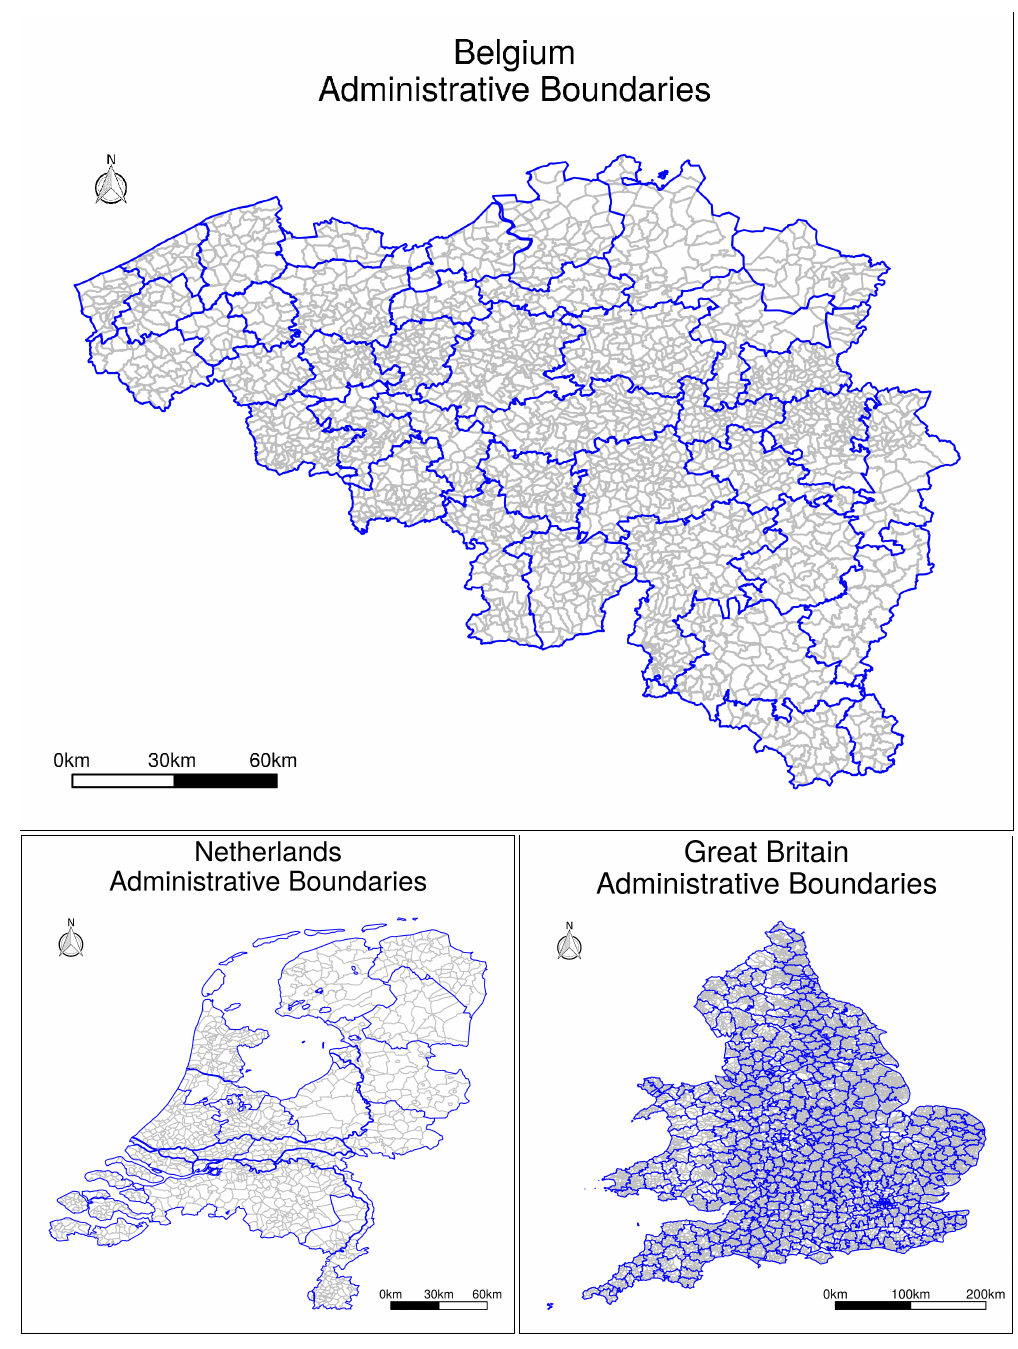
Figure 4. The boundaries for the source units associated to the three different